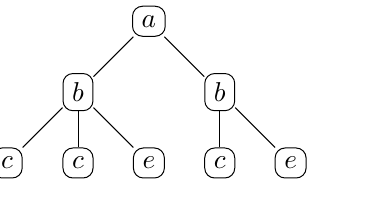
Figure 7. Example for the pruning procedure